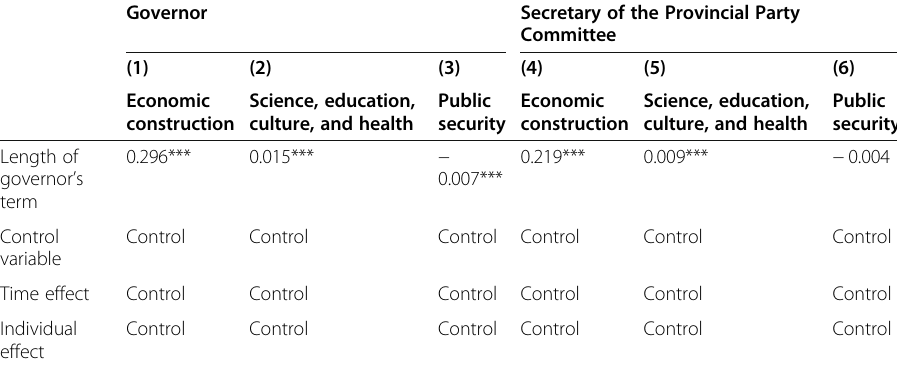
Table 9 Provincial data inspection after the expenditure classification reform